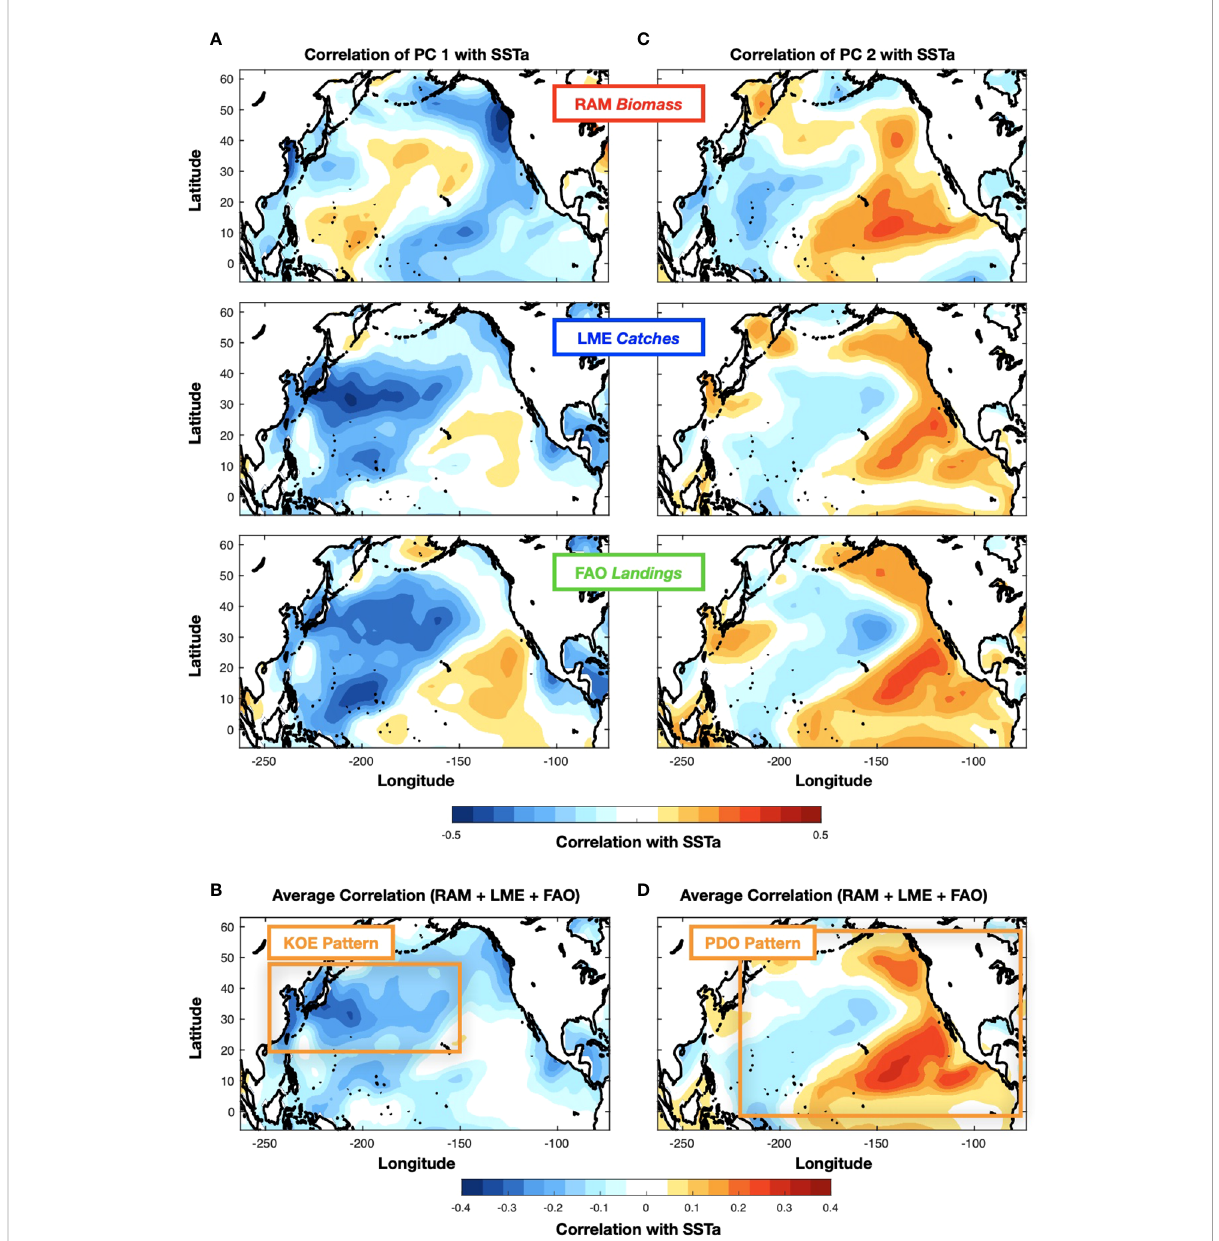
FIGURE 2 Correlation map between SST anomalies and PC1 (A) and PC2 (C) of the fi shery datasets (RAM, LME, FAO). The average correlation maps across the datasets for PC1 and PC2 are shown in (B) and (D)